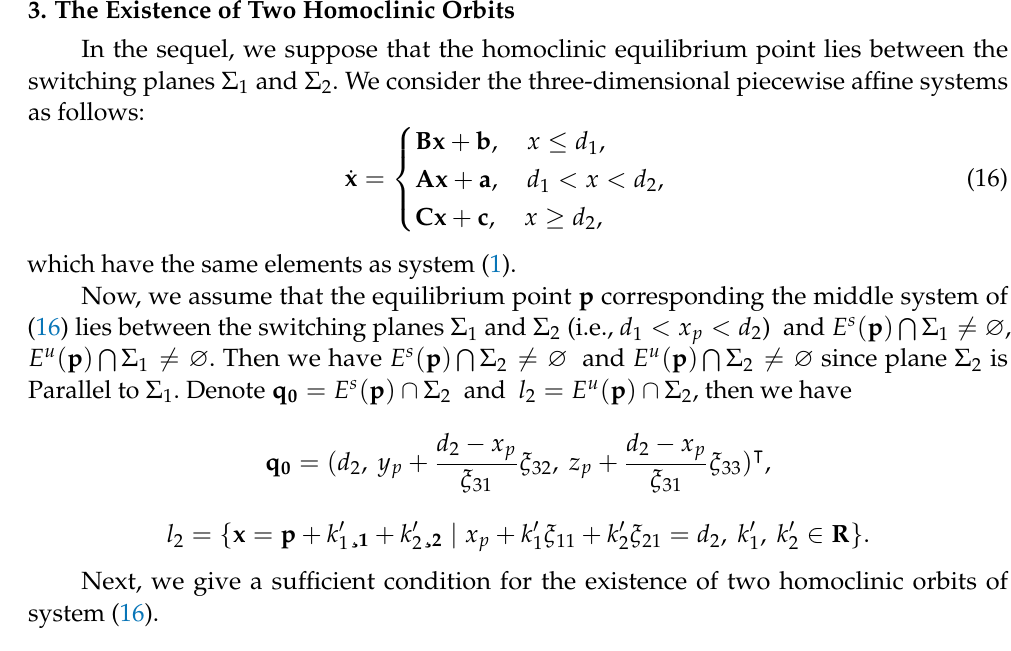
Figure 2. ( a ) The homoclinic orbit of Example 2 connects the equilibrium point p to itself which crosses the switching planes Σ Σ 2 transversally at p 0 , p 1 , q 0 , q 1 , respectively; ( b ) A chaotic invariant set of Example 2 near the homoclinic 1 and